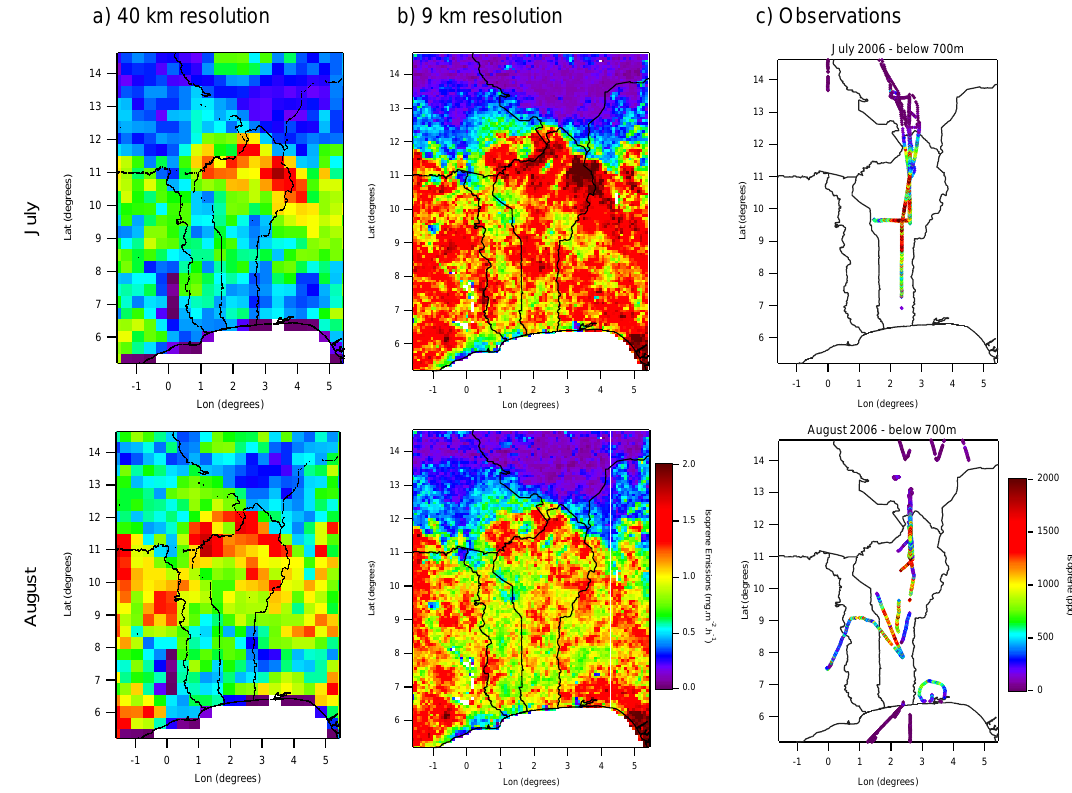
Fig. 7. Isoprene emission (mgm − 2 h − 1 ) estimates for (a) 40 and (b) 9km resolution MEGAN applications and (c) isoprene concentrations (ppt) measured during the AMMA Project field campaign on board the FAAM BAe-146 aircraft in July and August 2006. emissions (a temperature increase leads to higher emissions), but this meteorological parameter has little impact on their spatial variability, since the temperature itself does not vary much spatially (differences between adjacent grid cells are not higher than 3 to 5